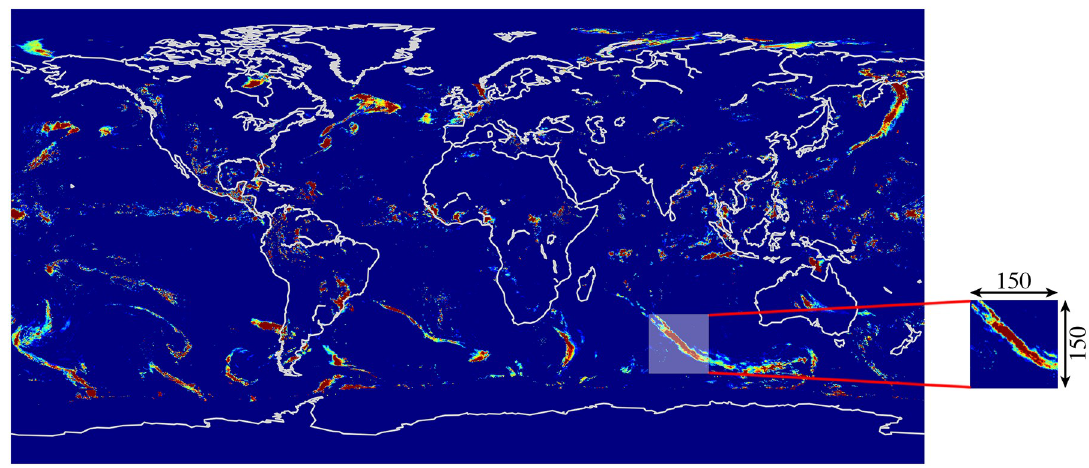
Fig 1. 150 x 150 crops from ‘ precipitatonCal ’ variable of the IMERG HDF5 file.